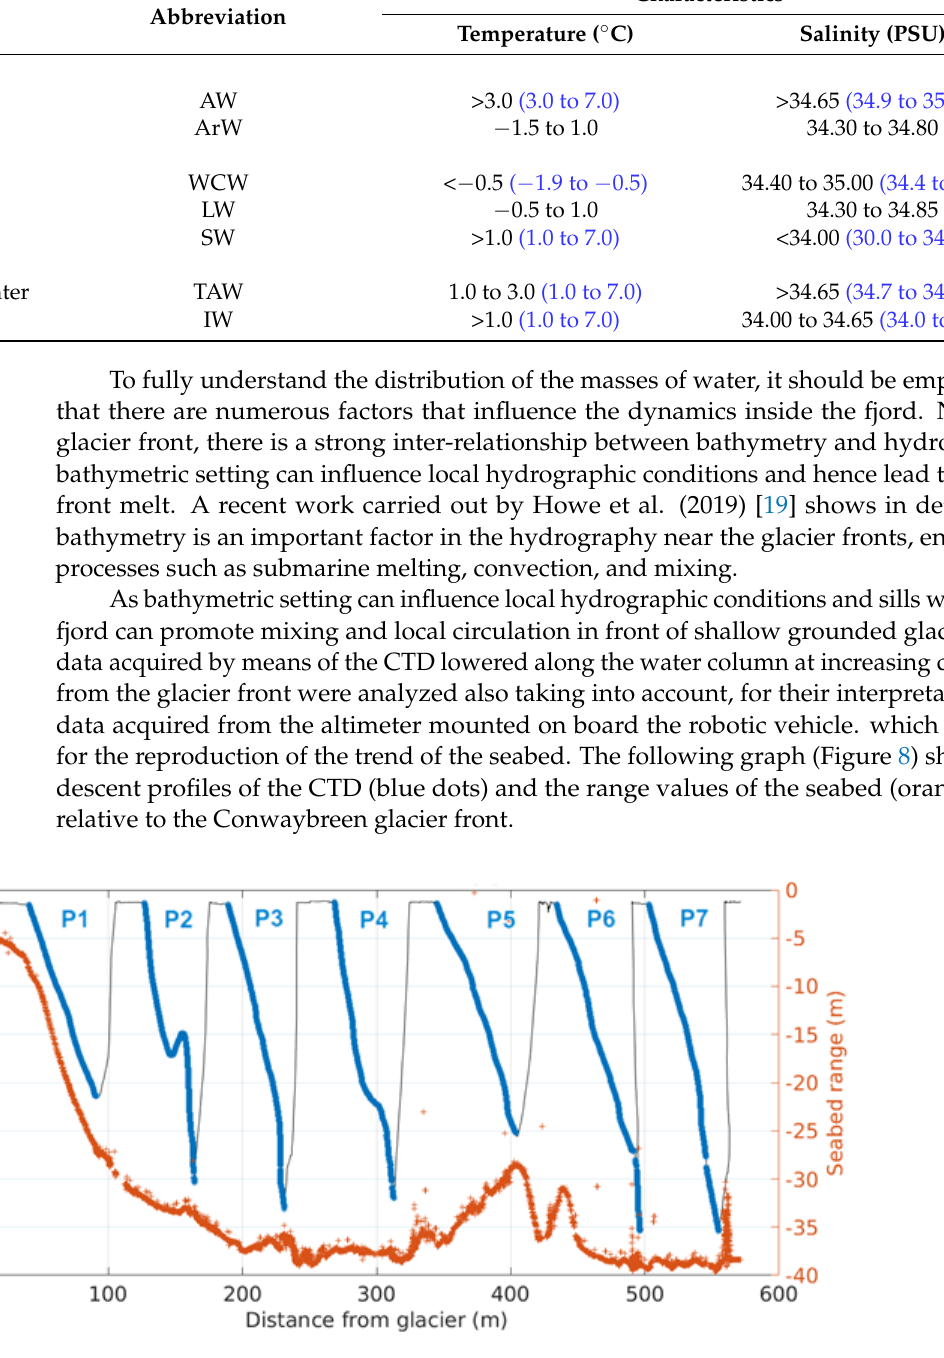
Figure 8. Graph of the descent profiles of the CTD (blue dots) as a function of the distance from the glacier, showing the trend of the seabed (orange dots) obtained from the data of the altimeter mounted on board PROTEUS. P1 is the CTD profile near to the glacier front (the first on the left side) and P7 is the CTD profile far from the glacier front (the last on the right).